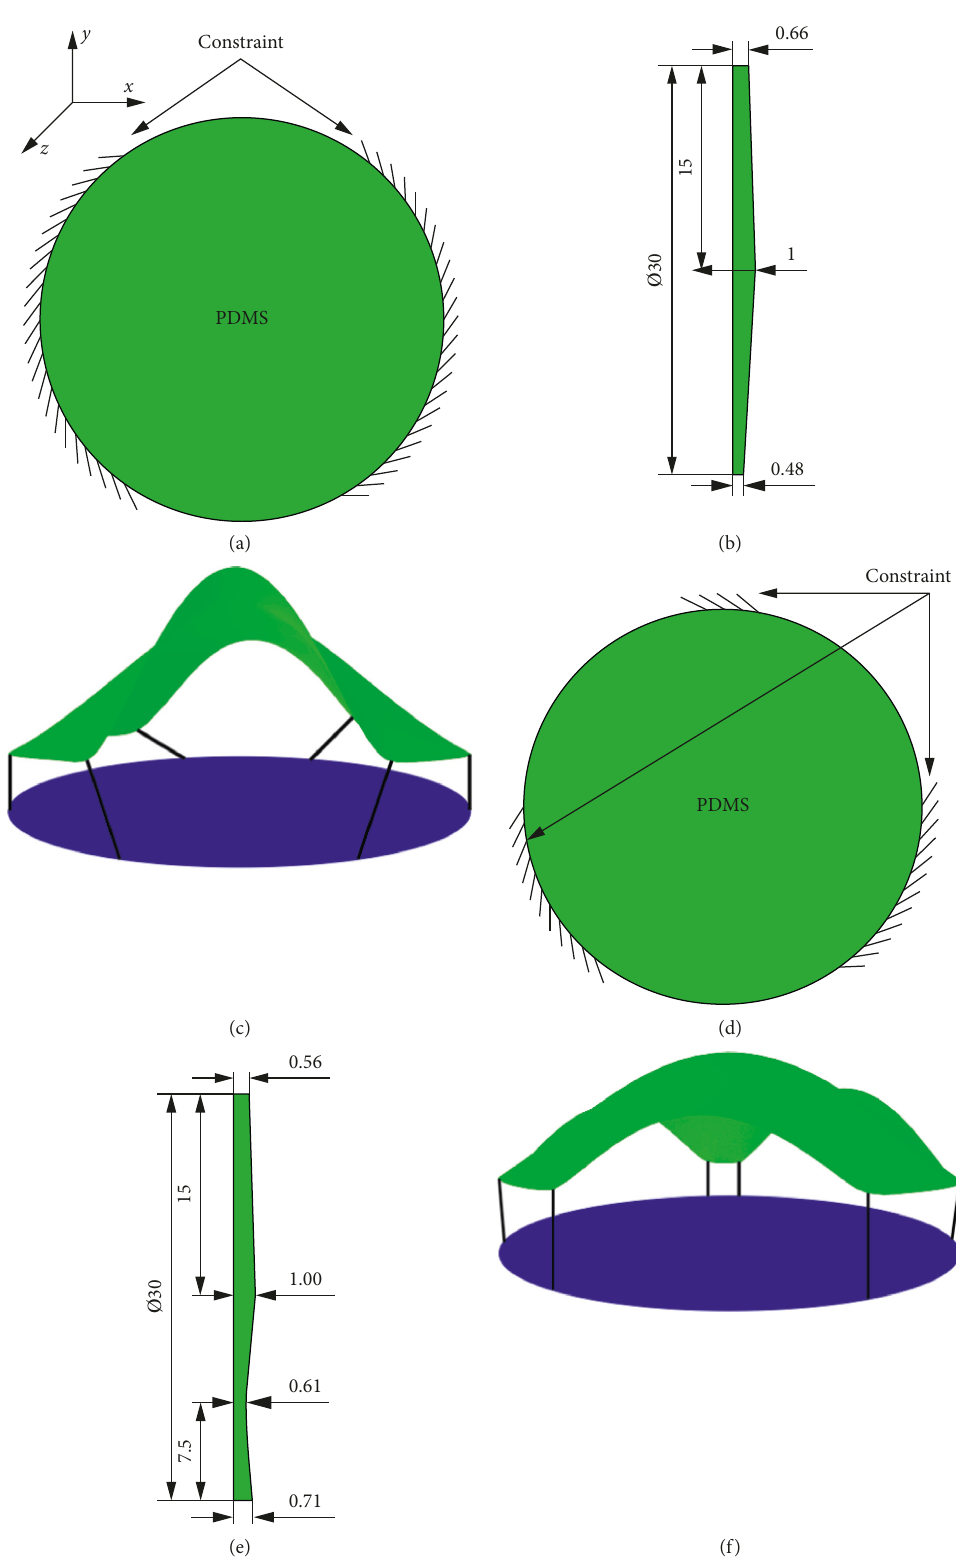
Figure 4: Model of geometry and surface structure of membranes. (a) Front view with constraint of two parts of edges clamped. (b) Side view with two directions inclined membrane. (c) Predicted freeform surface structure with constraint of two parts of edges clamped. (d) Front view with constraint of three parts of edges clamped. (e) Side view of a nonuniform thickness membrane. (f) Predicted freeform surface structure with constraint of three parts of edges